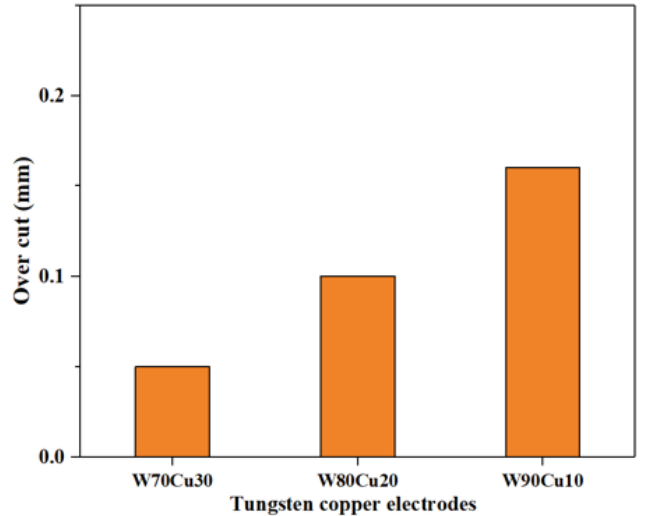
Figure 11. Tungsten–copper tool electrodes’ effect on side overcut under machining conditions T on = 12 μs, T off = 12 μs, I p = 14.17 A.